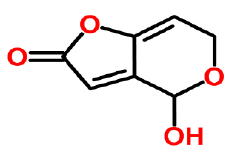
Figure 6. Patulin (structure from www.chemspider.com).